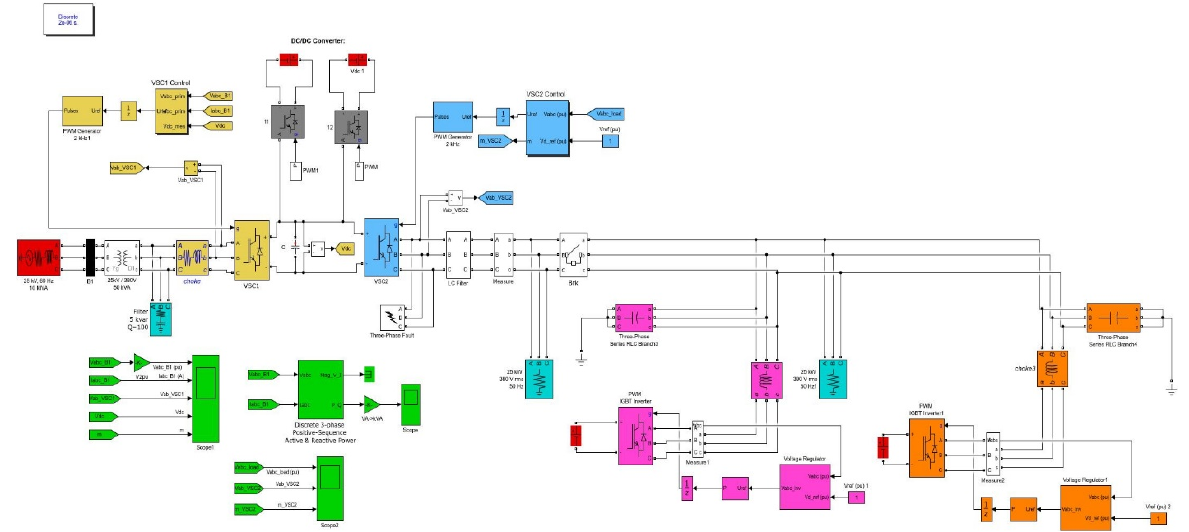
Figure 5. Studied simulation system.